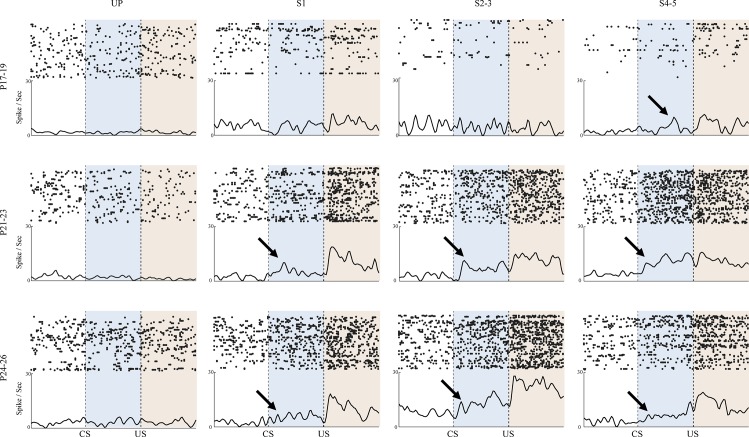
Representative examples of CA1 pyramidal cell firing.Examples of CA1 single pyramidal cell firing during eyeblink conditioning in rat pups given eyeblink conditioning on postnatal days (P) 17–19, P21-23, or P24-26. Rastergrams and perievent time histograms (PETH; bin size = 10 ms) of single neurons recorded during the unpaired (UP) session and following paired sessions (S1, S2-3, and S4-5). The neurons in the P17-19 group tended to fire randomly across the CS and US presentations until S2-3. In contrast, neurons in the older age groups showed increased firing rates during the post-US period as early as S1 and showed increased firing rates in the CS and post-US period as early as S2-3. Arrows note the start of significantly increased activity during the CS.